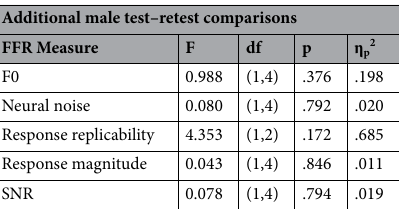
Table 3. RMANOVA results for male FFRs on remaining